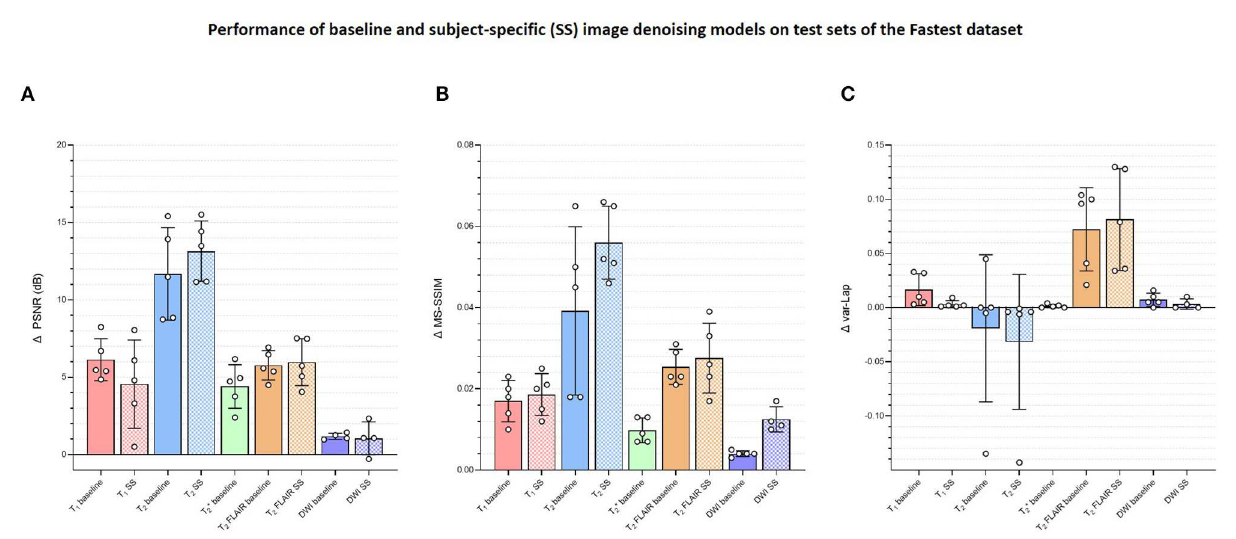
FIGURE7 Plots comparing the quantitative evaluations of the contrast-specific baseline and subject-specific (SS) image denoising models on the test sets of the Fastest dataset. The means of the changes in (A) PSNR (dB), (B) MS-SSIM, and (C) variances of the Laplacian (var-Lap) values are reported. Lowest validation loss models were used in all instances. Higher PSNR and MS-SSIM indicate larger improvements in the image quality of the denoised images. Higher varLap values indicate improvements in sharpness of the denoised